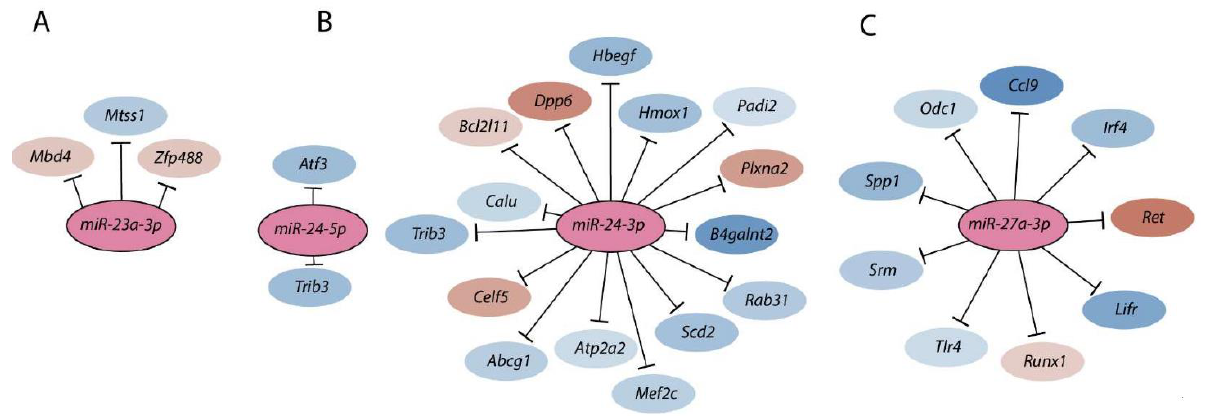
Figure 4. Members of the Mirc11 family target multiple transcripts. Members of the Mirc11 cistron miR-23a ( A ), miR-24-2 ( B ), and miR-27a ( C ) have the potentials to silence the translation of hundreds of mRNAs by targeting unique ‘seed’ sequences present in their 3′-UTR. Using TargetScan 7.1-based in silico analyses (http://www.targetscan.org, accessed on 28 July 2021), potential target transcripts in the total genome-wide RNA sequencing data were identified from NK cells based on ‘the aggregate probability of conserved targeting’ (P CT ). The ENCODE Data Coordination Center portal-based whole-genome alignments were used to determine the transcripts that are the targets of Mirc11 family members. A select few target transcripts of the Mirc11 cistron are shown.